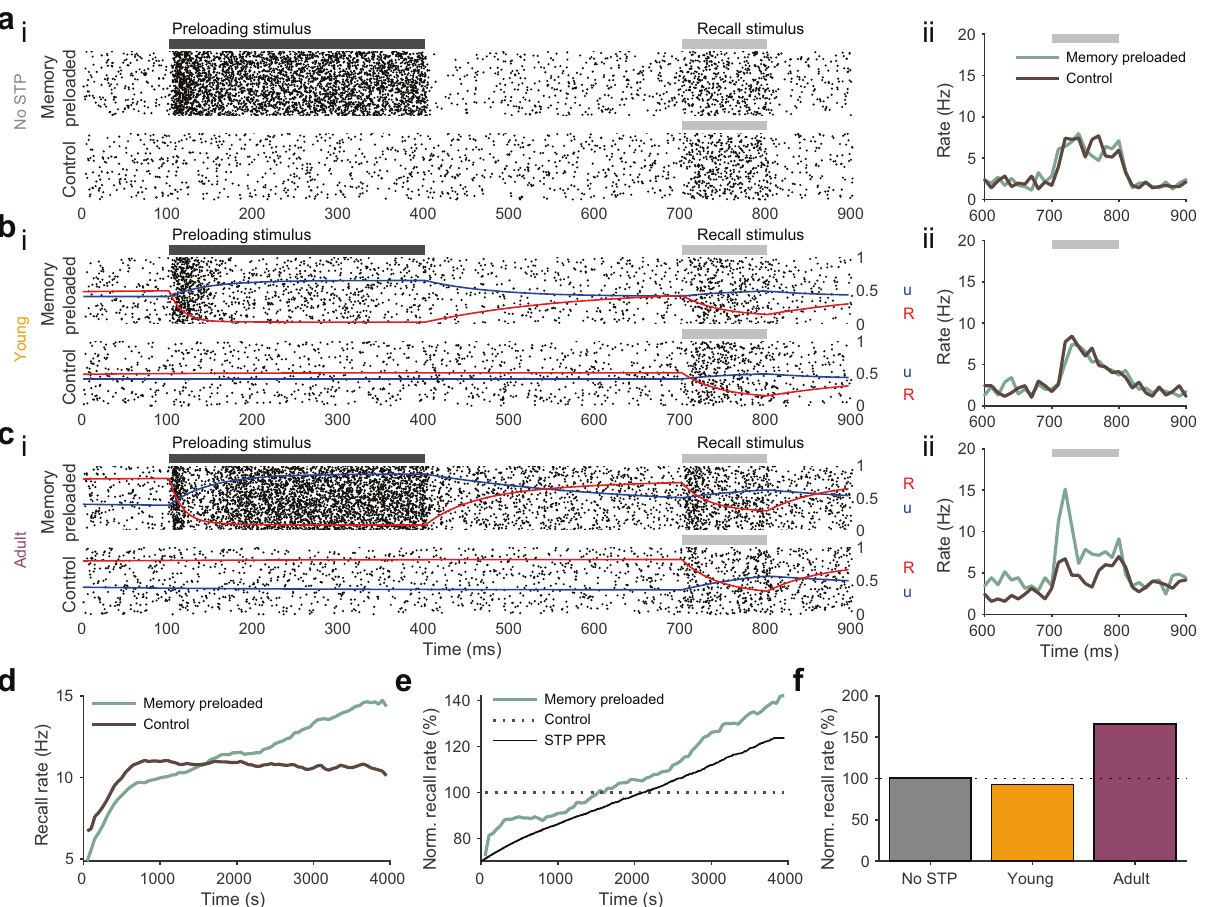
Fig. 7 Gradual emergence of synaptic-based short-term memory traces over development. a – c Raster plot of short-term memory test (SMT, i-top)) with a preloaded stimulus and subsequent recall stimulus (black and gray bars, respectively) compared with raster plot of trials without the preloaded stimulus (i-bottom). Average fi ring rates (ii) for both memory preloaded (light green) and control conditions (dark brown). Release probability (u in blue) and number of presynaptic resources (R in red) are also given for reference (see Methods). a SMT in a model with only inhibitory synaptic plasticity (i.e. no STP). b SMT in a model with young STP pro fi le. c SMT in a model with adult STP pro fi le. d Firing rates during the recall period with (light green) or without (dark brown) preloaded stimulus. SMTs were preformed every 50 seconds during dev-STP development simulation (cf. Fig. 2) as STP changes from depression to facilitation at excitatory synapses. We only highlight the fi rst 4000 s of the simulation as after this point changes in STP become minimal. e Normalized recall fi ring rates to the average fi ring rate of the control case (i.e., without memory preloading). The STP paired-pulse ratio (black) measuring the STP strength of the excitatory synapses for this period is also plotted as reference. f Normalized recall rate for three model conditions: no STP (gray), young STP (orange), and adult STP